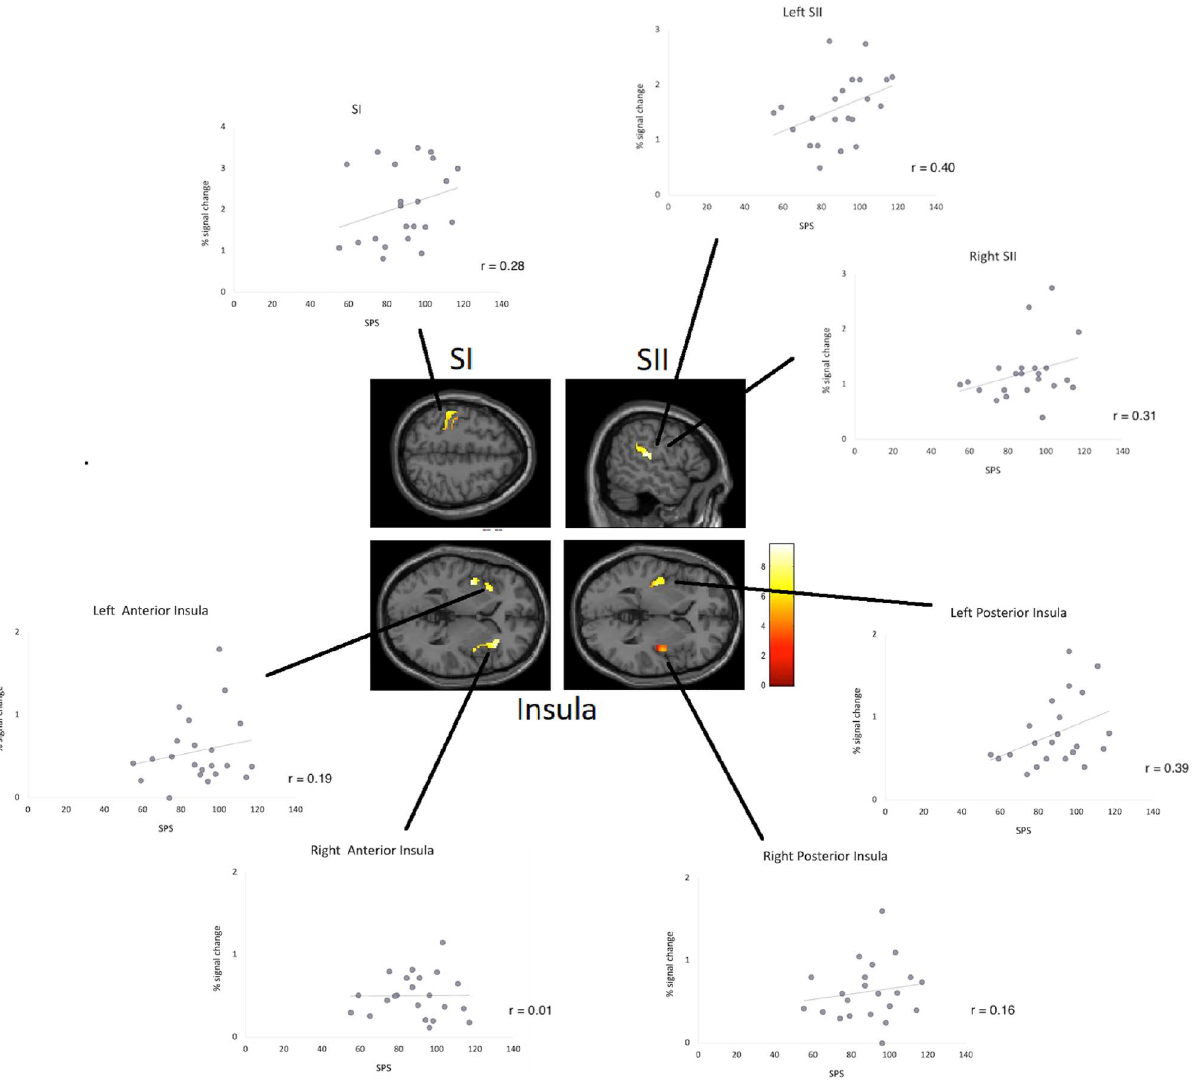
Figure 3. Brain responses when participants were touched by a hand. Scatterplots show relationships between SPS and peak activation of regions of interest (SI, bilateral SII, and insula cortices) (at p < 0.001, uncorrected, for picture display purpose only). Results revealed positive correlations of SPS with SI, SII and left posterior insula, but these correlations hold only for posterior insula when controlling for related personality traits (MNI coordinates, SI: − 50, − 30, 52; right SII: 62, − 16, 20; left SII: − 54, − 28, 20; right anterior insula: 36, 24, 9; left anterior insula: − 30 16 2; right posterior insula: 42, − 8, 2; left posterior insula: − 36, − 18,